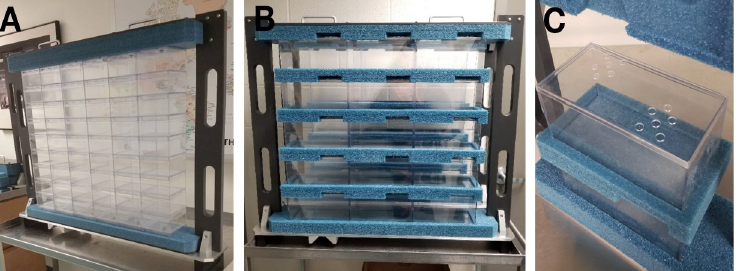
Fig 12. Housing array for mouse (A) and rat (B) irradiations in the 60 × 60 cm 2 beam. Exposure boxes, made of approximately 2-mm thick polyethylene, stack together and are held in an array using a fabricated frame strucure. (C) Ventilation lids for air circulation are provided. The nonventilated sides of the lids are painted red to serve as a quick visual cue that the lids are in the correct orientation for air flow.